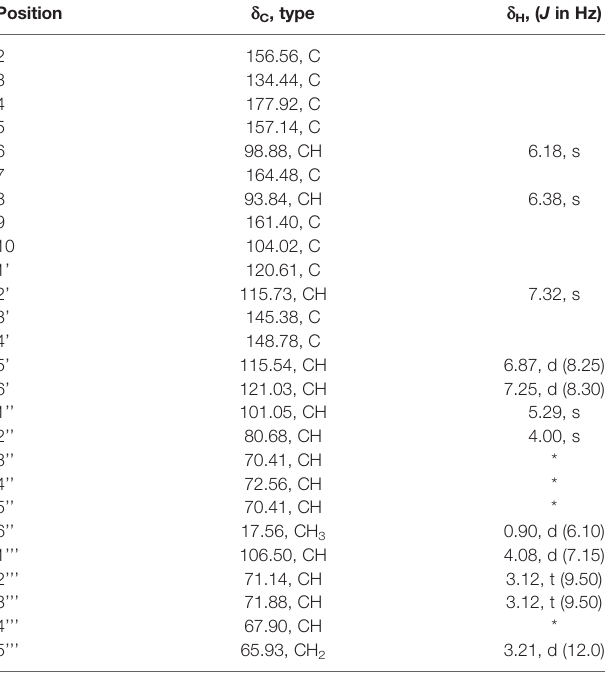
TABLE 1 | NMR spectroscopic data (500 MHz, DMSO- d 6 ) for compound 1.